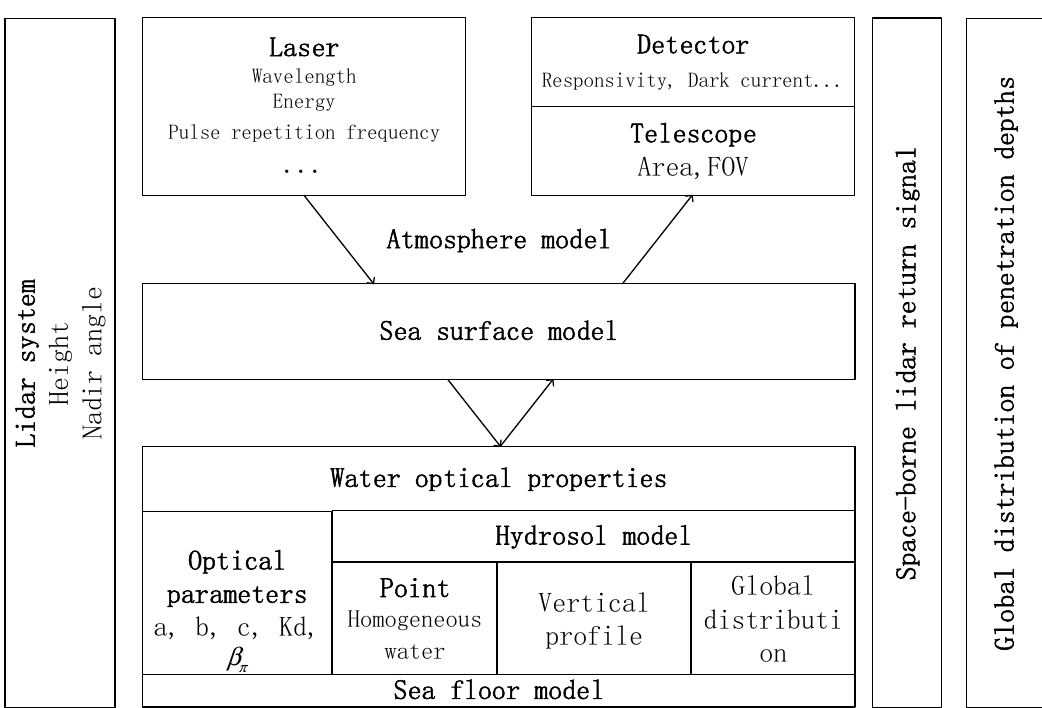
Figure A1. The framework of SOLS.